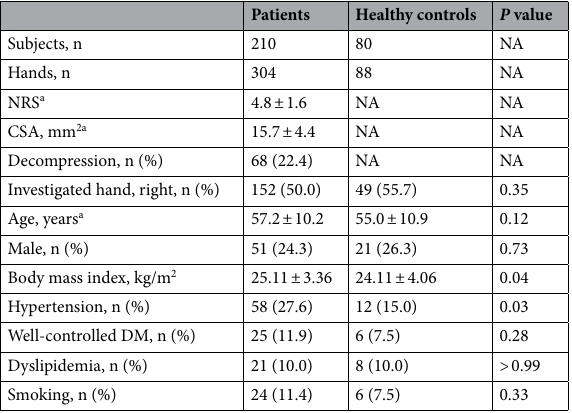
Table 1. Characteristics of the subjects. NA not applicable, NRS numerical rating scale of pain, CSA cross-sectional area of the median nerve, DM diabetes mellitus. a All continuous values were expressed as mean ± standard